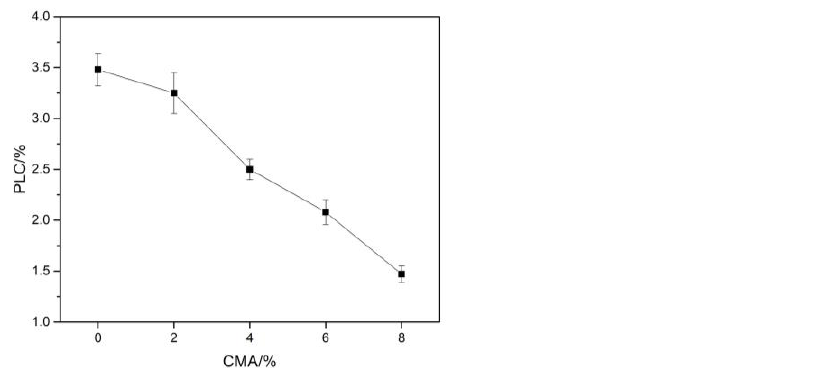
Figure 6. Permanent linear change (PLC) of specimens sintered at 1600 °C for 3 h.